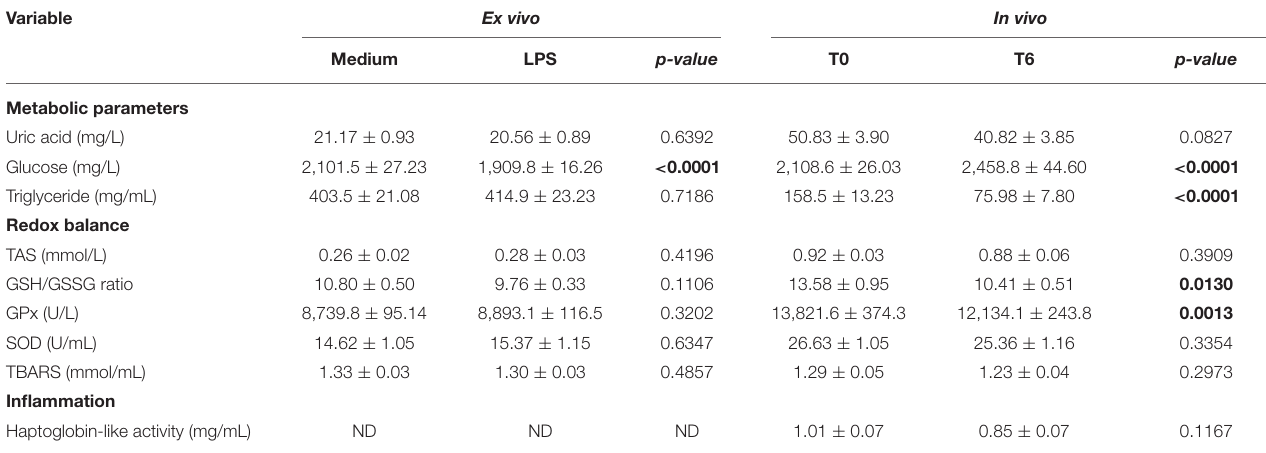
TABLE 6 | Effects of LPS on metabolic parameters, redox balance and inflammation indicators in blood cells incubated for 6h with LPS ( ex vivo ) or from blood sampled 6h after LPS subcutaneous injection ( in vivo ). Variable Ex